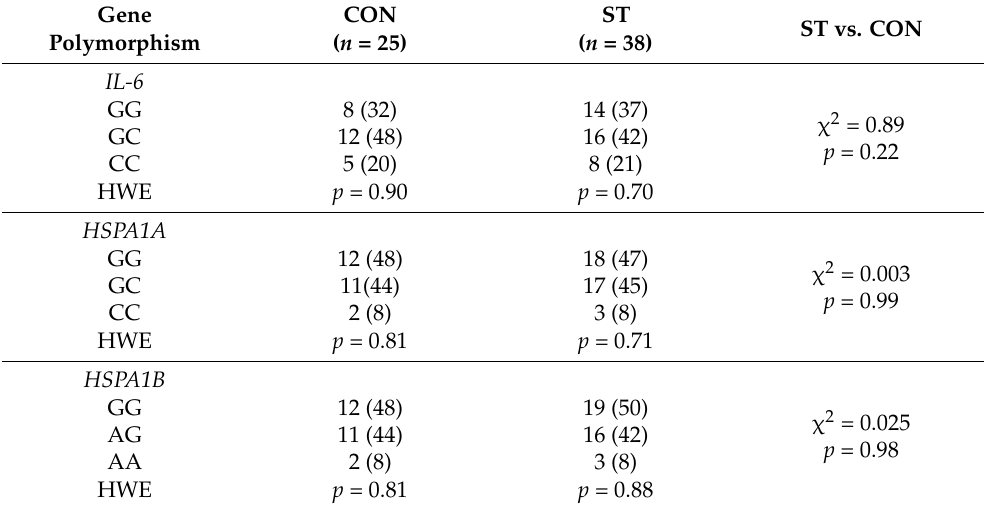
Table 3. The distribution of genotypes for gene polymorphisms in control (CON) and swimming training (ST) group ( n ;